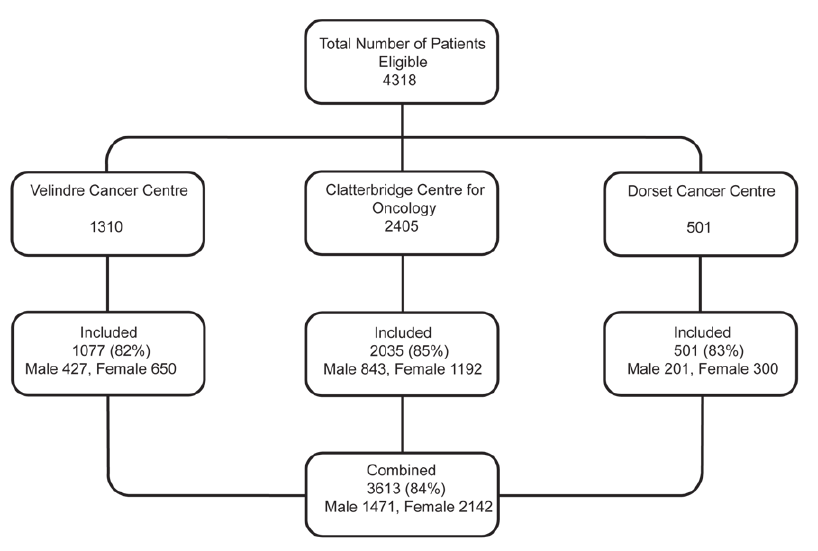
Figure 1. Patient identification and inclusion in study. Only cases in which a full dataset could be obtained were included in the study. This was possible for over 80% of patients in all 3 centres, with only a relatively small number excluded, mainly due to misfiling or loss of chemotherapy scripts.